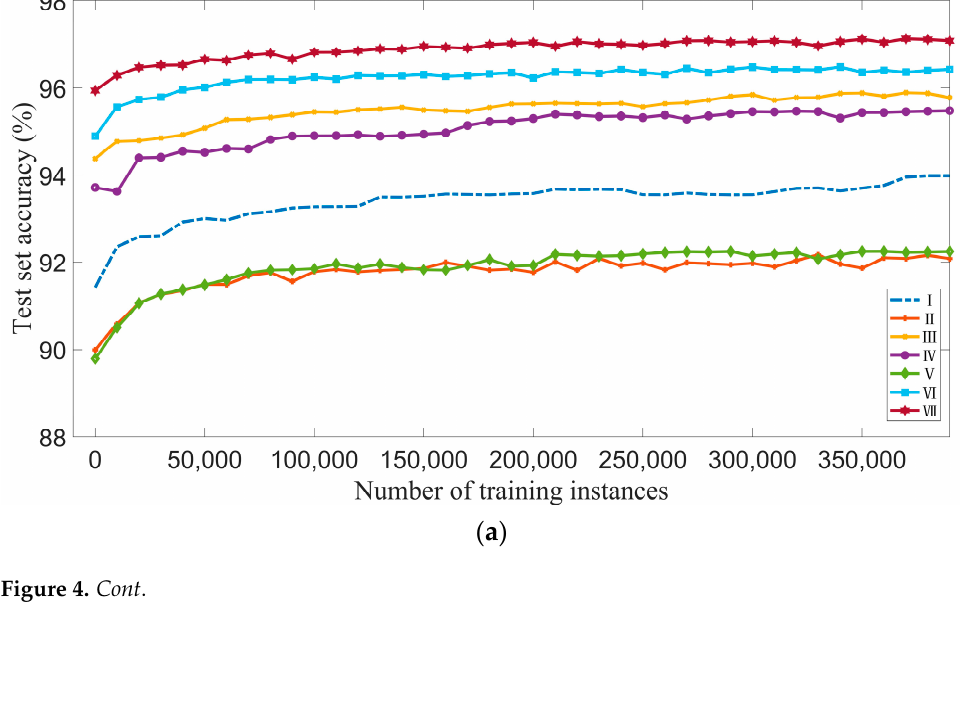
( b ) Figure 4. The overall accuracy of different SVM model experiments in ( a ) Arctic and ( b ) Antarctic regions. 4.3. Evaluation of Sea Ice Distribution Model Precision A more detailed evaluation of the selected SVM model (i.e., experiment VII), which inputs all available characteristic parameters from HSCAT, CSCAT, and ASCAT meas- urements, is performed. Again, we use NSIDC SIC data as reference data. The evaluation indicators include accuracy, precision, recall, and F1 score. The accuracy gives the overall prediction accuracy of the model. The precision is defined as the proportion of correctly predicted samples to total samples. The recall represents the probability of the samples being correctly predicted. The F1 score is an index used to measure the accuracy of a clas- sification model that takes into account both the precision and recall of the classification model. It should be noted that, in the confusion matrix, the true positive (TP), true negative (TN), false positive (FP) and false negative (FN) is defined differently for each type. There- fore, the values of any precision, recall and F1 scores can be defined as follows: (cid:1842)(cid:1870)(cid:1857)(cid:1855)(cid:1861)(cid:1871)(cid:1861)(cid:1867)(cid:1866) = (cid:1846)(cid:1842) (cid:1846)(cid:1842) + (cid:1832)(cid:1842)